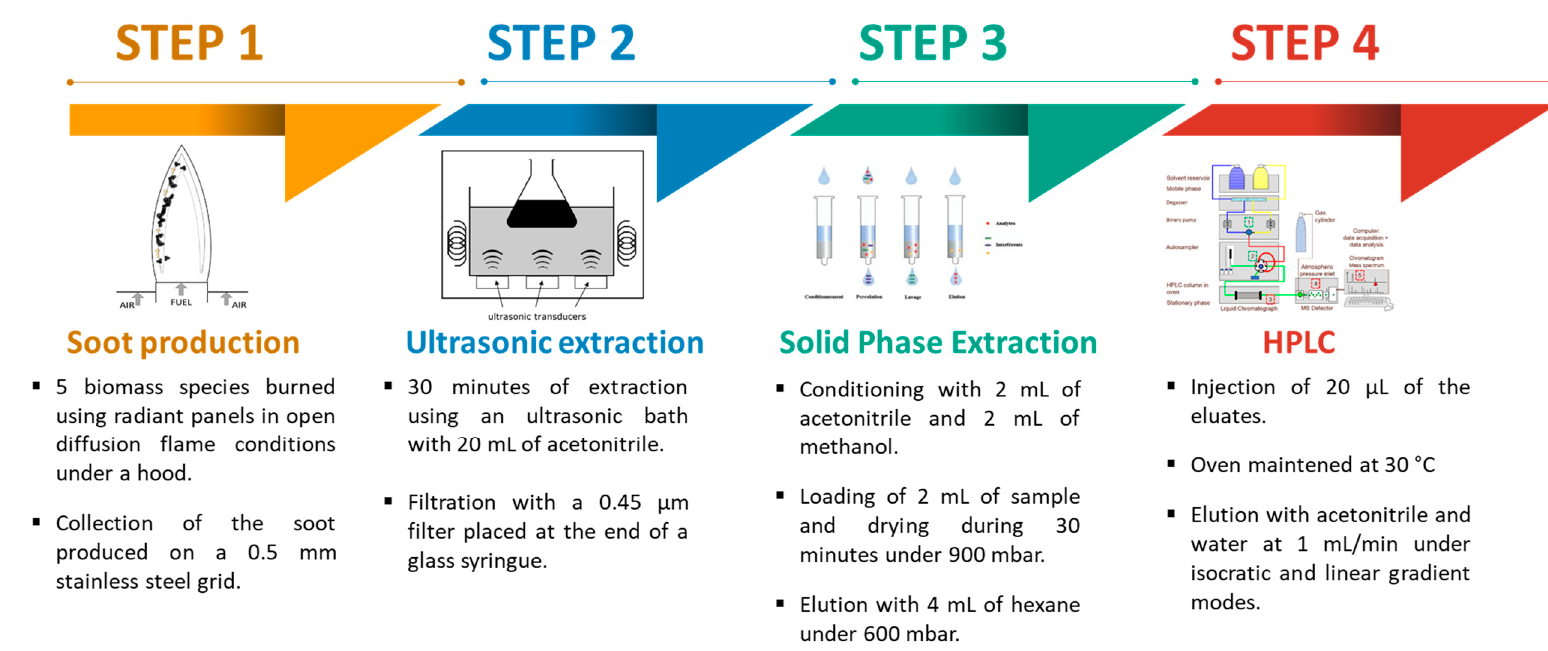
Figure 1. Overview of the analytical method.